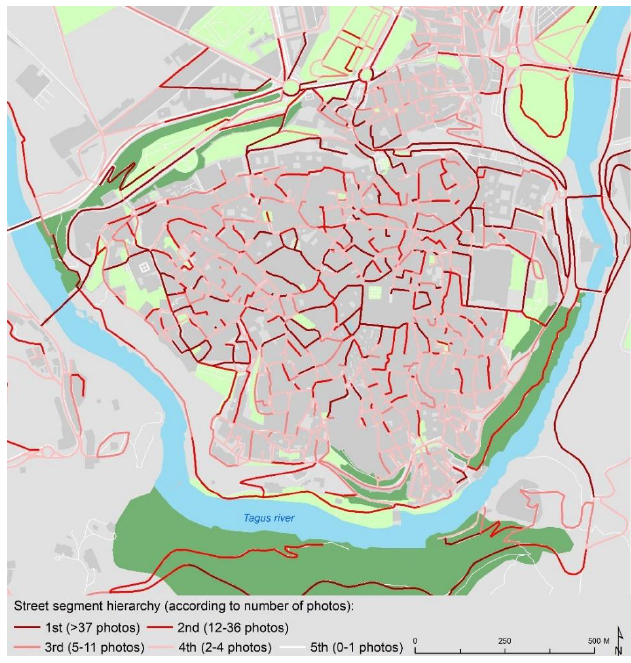
Figure 6. Street segment hierarchy according to number of photos assigned. Source: Authors’ own